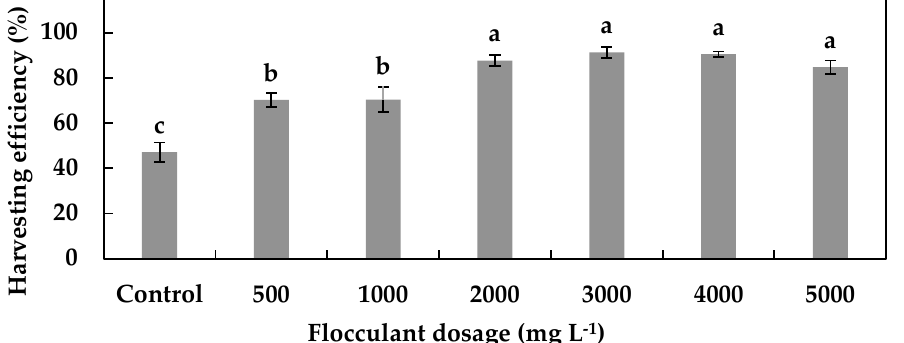
Figure 4. Effect of six different doses of M. oleifera seed powder water extract (20 g L − 1 ) on the harvesting efficiency of a mixed culture of Chlorella and Desmodesmus (500 mg L − 1 ) after a 60-min sedimentation time. Control without the addition of flocculants was also carried out in the same conditions as the assays with the addition of flocculants. The rotation speed and time used were 150 rpm for 5 min, followed by 30 rpm for 10 min in an orbital shaker. Columns represent the average values, and error bars represent the standard deviations of triplicates. Different letters indicate significant differences between the different dosages of dissolved M. oleifera powder after a one-way ANOVA followed by a Tukey test ( p < 0.05).